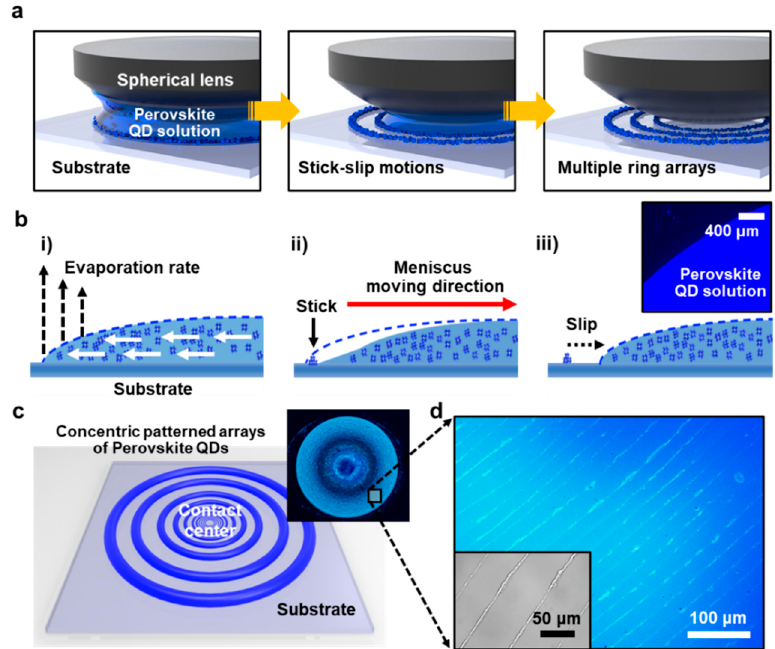
Figure 2. Evaporative self-assembly of the perovskite QDs in a sphere-on-flat geometry. ( a ) Stepwise schematics of the formation of the multiple ring arrays via drying-mediated assembly process of colloidal perovskite QDs. A sphere-on-flat geometry forms a capillary-held solution with the maximum evaporative loss of solvent at the capillary edge, which leads to repetitive stick-slip motions. ( b ) Cross-sectional demonstration of a perovskite QD ring formation by a stick-slip event. The dotted line represents a change of both the contact angle of the colloidal QDs solution and the solution volume of the meniscus. ( c ) Schematic of a concentric patterned array of the perovskite QD rings after the complete solvent evaporation and a digital image of CsPbBr 3 QD multiple ring arrays under UV irradiation. ( d ) A representative optical micrograph of highly ordered perovskite QD rings formed on a SiO 2 /Si substrate. The inset image shows a phase-contrast image for tiny stripes of CsPbBr 3 on a glass substrate.